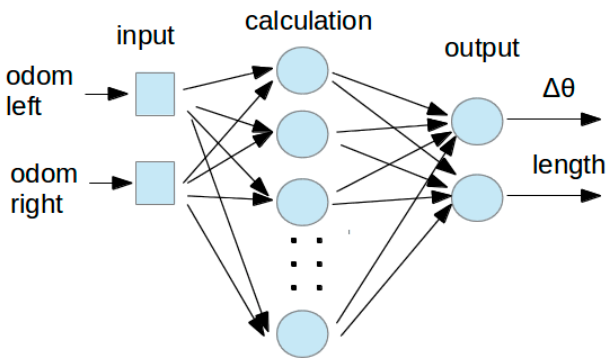
Figure 8. Feed-forward neural network schematic for odometry.